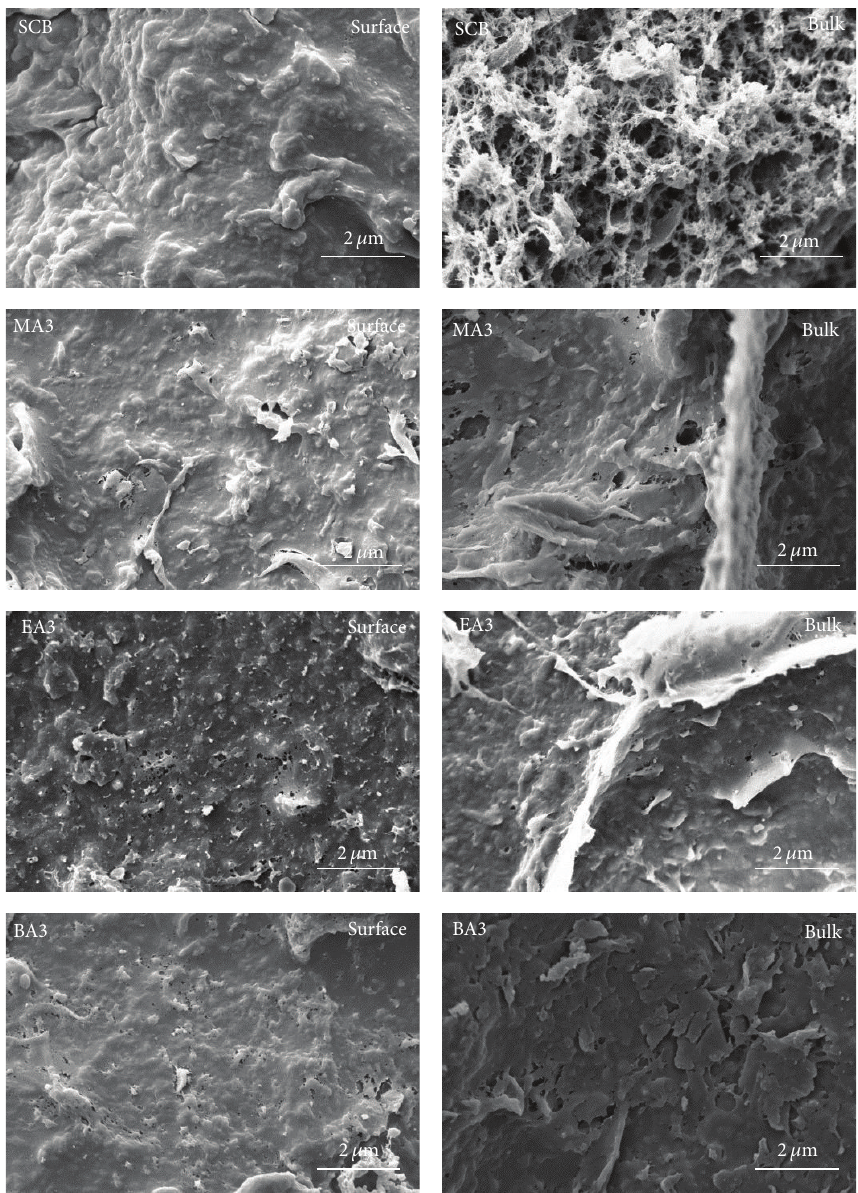
Figure 4: SEM photos of the sugarcane bagasse graft